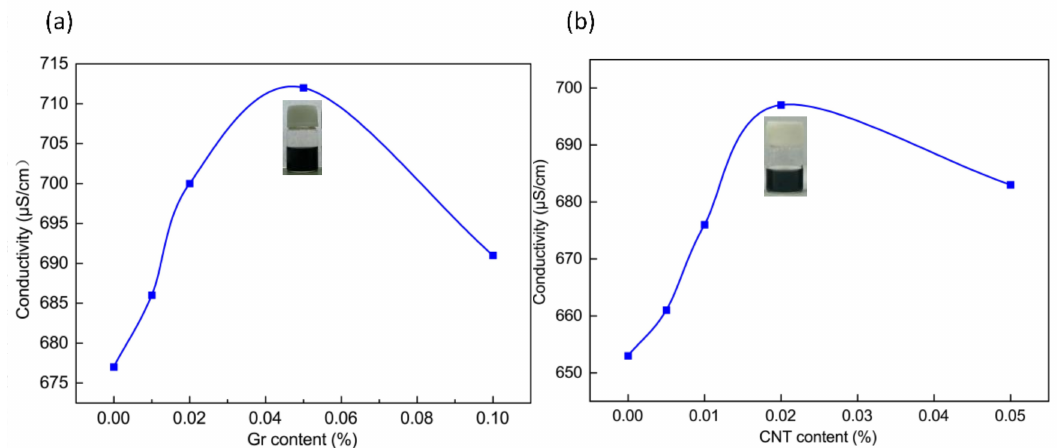
Figure 2. Conductivity of di ff erent concentrations of ( a ) Gr-PVA solution and ( b ) CNT-PVA